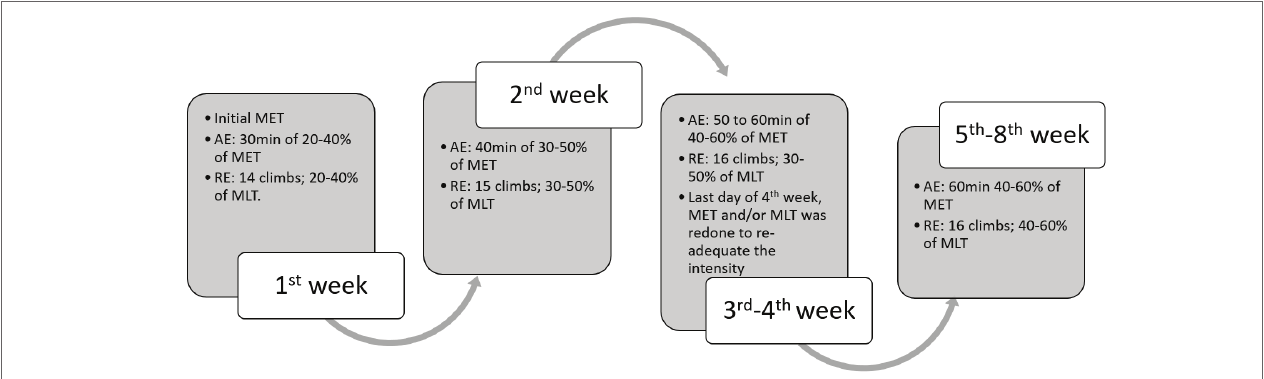
FIGURE 1 | Schematic figure of aerobic and resistance exercise session. Aerobic exercise training was performed 5 days/week, during 8 weeks. Resistance exercise training was performed 5 days/week, during 8 weeks. Combined exercise training was performed 5 days/week, in alternate days (1 day aerobic and the other day resistance training) during 8 weeks. AE, aerobic exercise; RT, resistance exercise; MET, maximal exercise test; MLT, maximal load